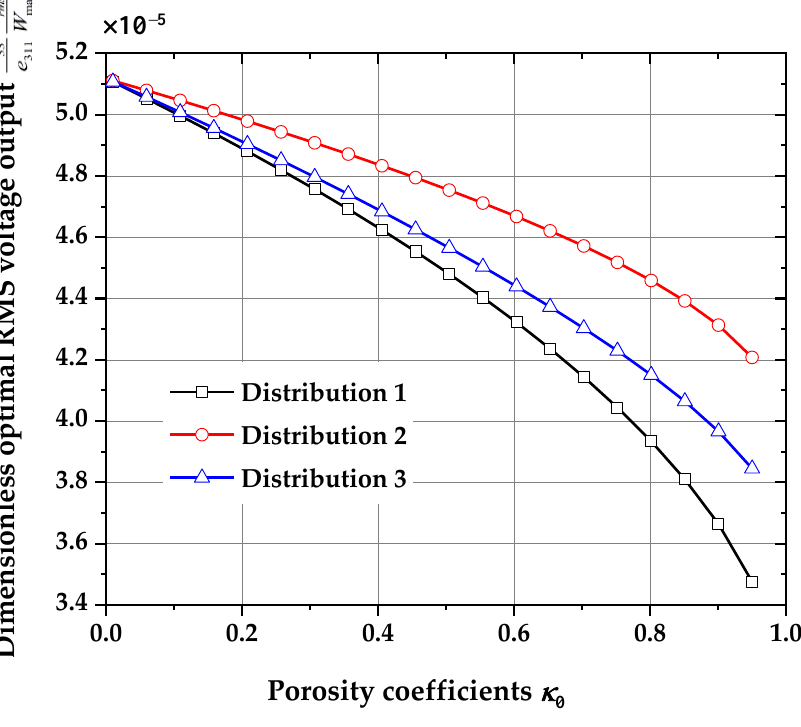
V rms ) – porosity coefficients e 311 W max